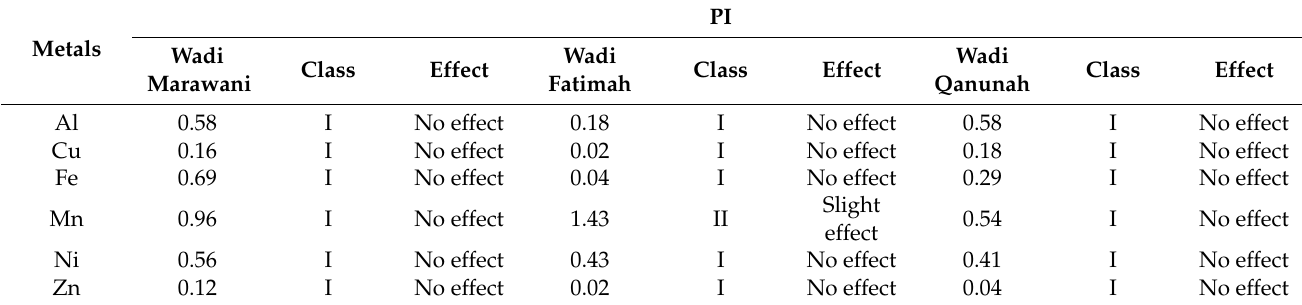
Table 7. Groundwater quality assessment for the selected wadies in Makkah Al-Mukarramah Province based on metal